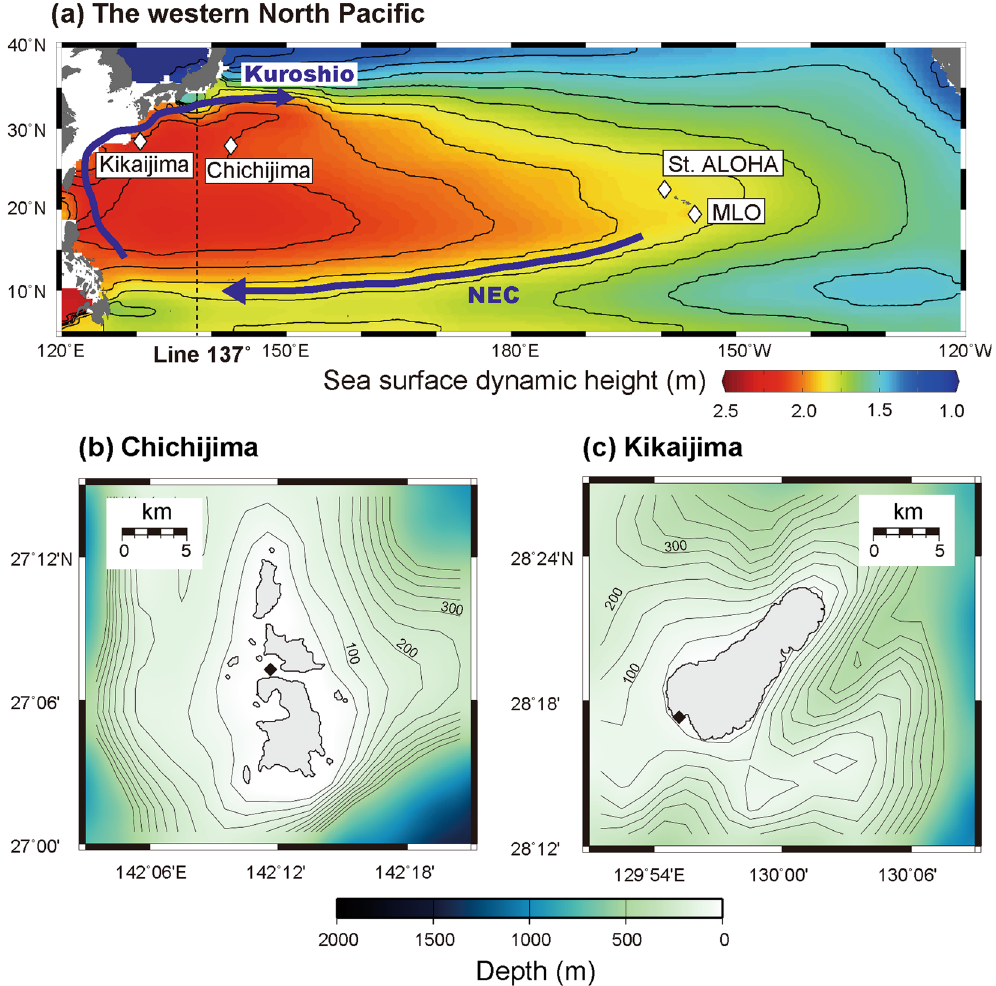
Figure 1. Location of Chichijima and Kikaijima in the North Pacific Ocean. ( a ) Contours indicate climatological mean sea-surface dynamic height (in units of metres relative to the 1000 m level), with arrows showing the major surface ocean currents in the western North Pacific. Data were downloaded and plotted with the ODV software, version 4.6.2 (ref. 43, http://odv.awi.de). MLO, Mauna Loa Observatory. ( b , c ) Bathymetric maps around Chichijima and Kikaijima. Depth contours are at 50 m intervals. The GMT software, version 4.5.8 (ref. 44), was used to map the bathymetric data, ETOPO1 (ref. 45, https://www.ngdc.noaa.gov/mgg/global/ global.html). The corals were collected at a location with good open ocean seawater circulation (black dot) (Supplementary Figs S7 and S8) 10, 11